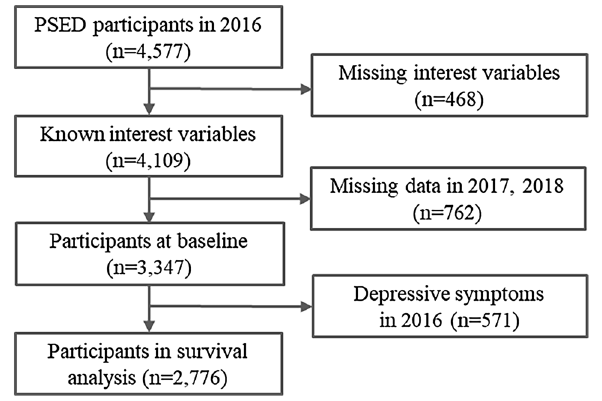
Figure 1. A schematic diagram of the study